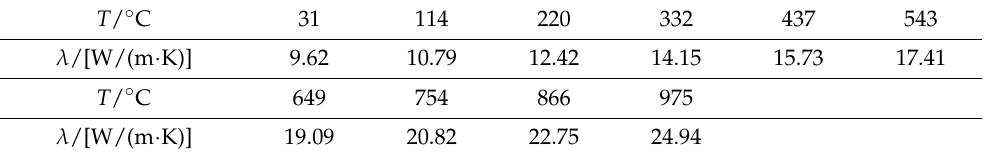
Table A1. Thermal conductivity ( λ ) of stationary solid material.